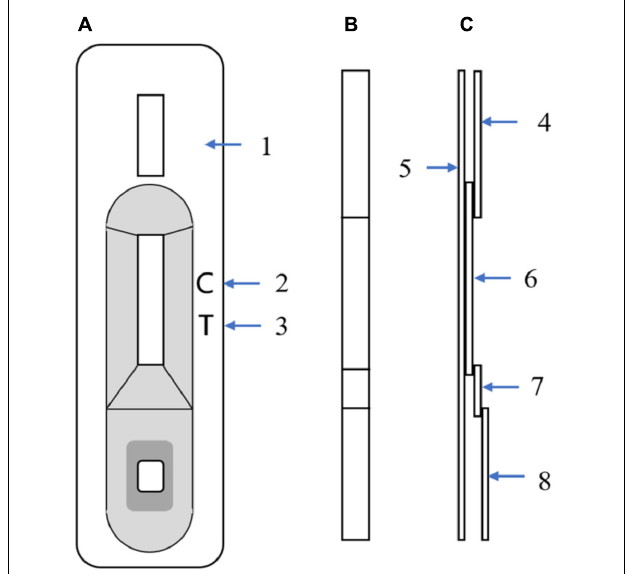
FIGURE 1 | Schematic diagram of the immunochromatographic strip (ICS). (A) Front view of the ICS; (1) Plastic box, (2) Control-line position, (3) Test-line position (mAb 2C1, 1 mg/ml). (B) Strip front view. (C) Strip side view; (4) Absorbent paper, (5) PVC sheet, (6) Nitrocellulose membrane with control line and test line, (7) Glass-fiber membrane with mAb 7D7 (10 µ g/ml), and (8) Glass-fiber